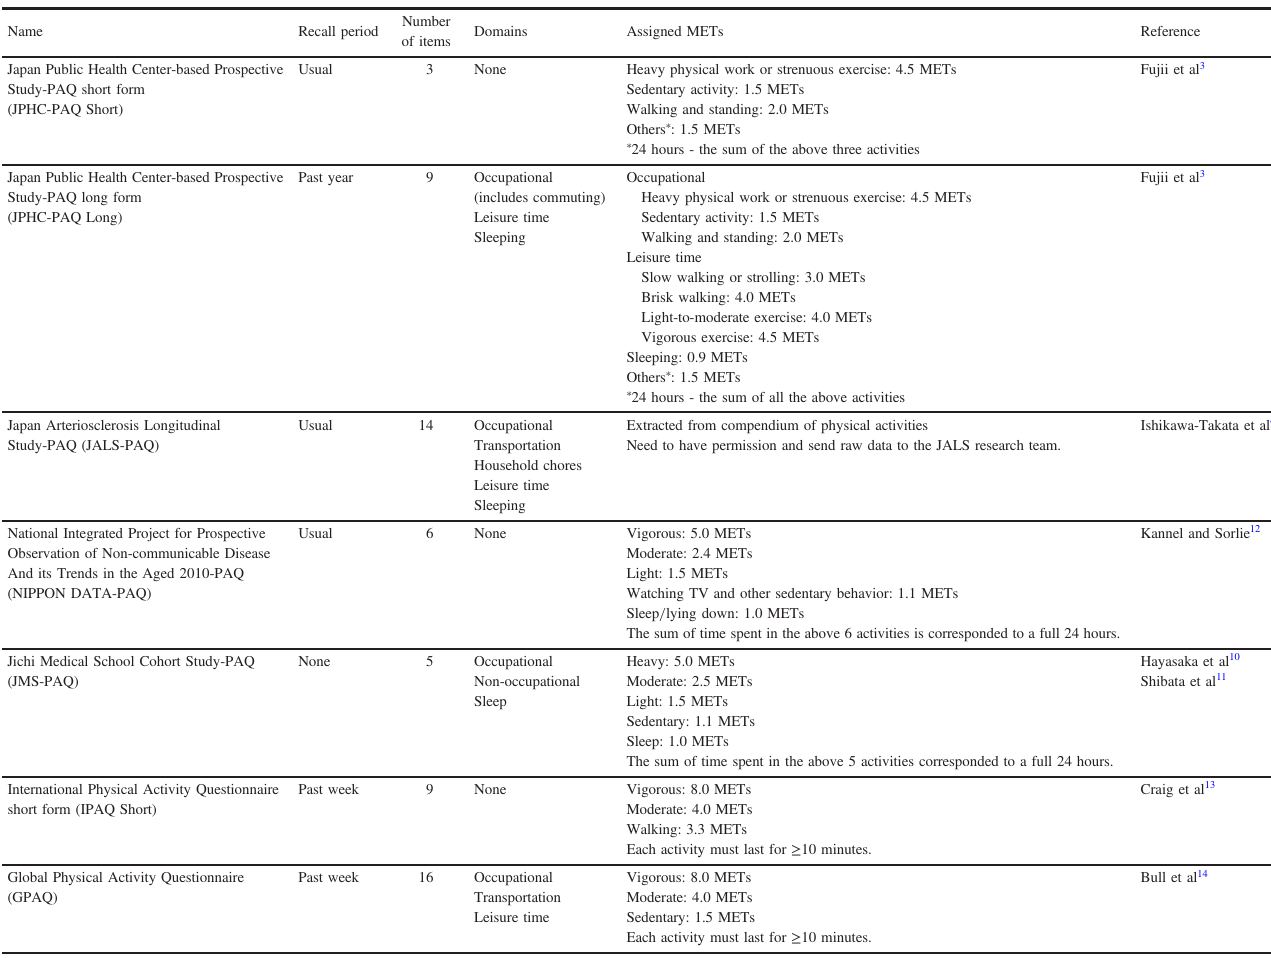
Table 1. Characteristics of physical activity questionnaires used in this study